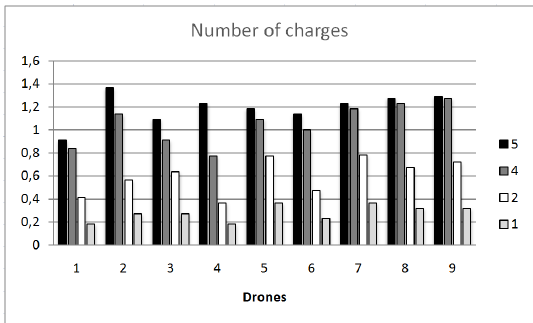
Figure 11. Number of charges varying charging stations number.